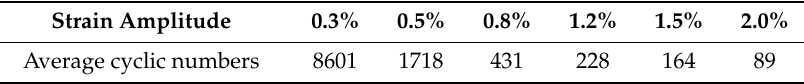
Table 2. The average fatigue life at di ff erent strain